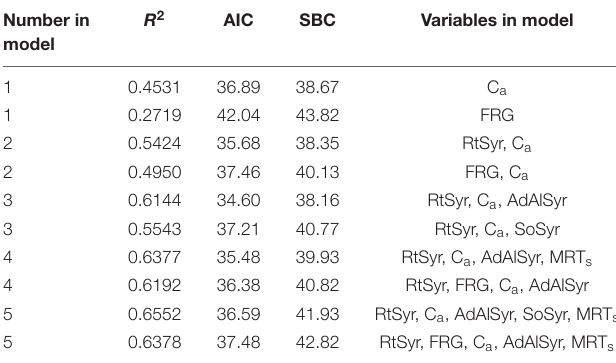
TABLE 5 | Multiple regression results for the effects of six explanatory factors on SOC